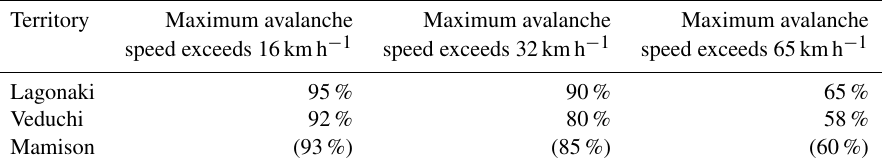
Table 6. The percentage of the area where the maximum avalanche speed exceeds the average movement speed of sportsmen (16, 32 and 65kmh − 1 ).